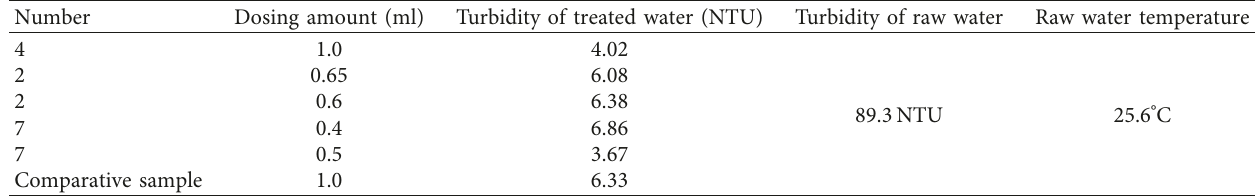
Table 12: Comparison experiment of formula nos. 2, 4, and 7 and contrast sample.